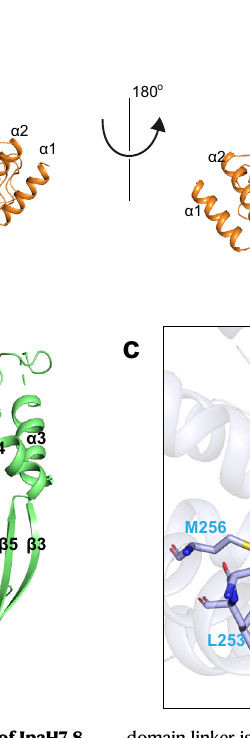
domain linker is colored pink. c Close-up view of the intramolecular interactions involved in the NTD-CTD interface. Polar interactions are indicated by yellow dashed lines.